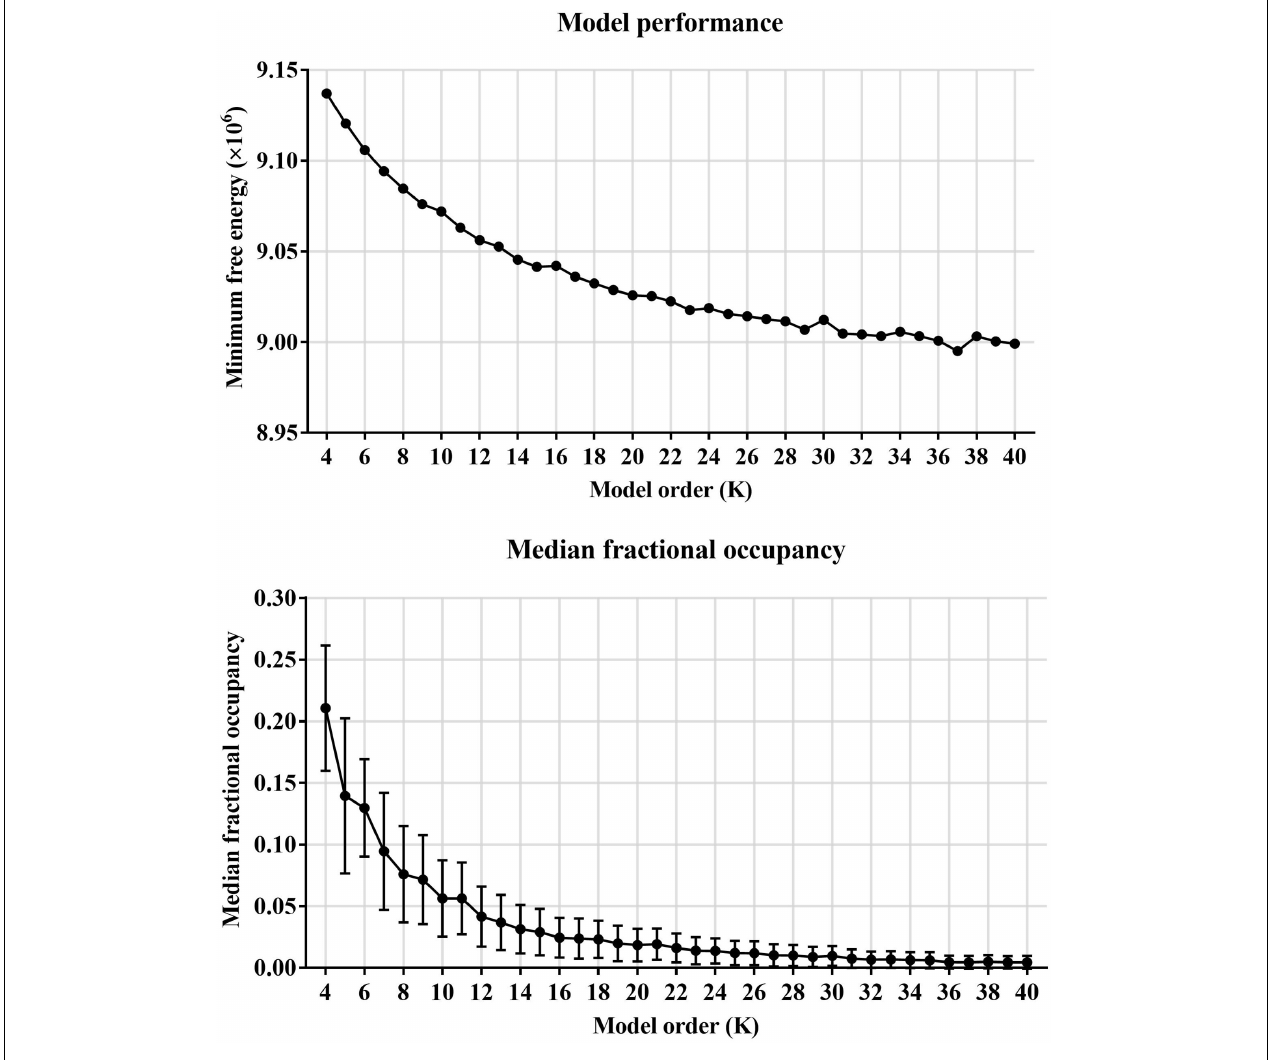
FIGURE 2 | The choice of the number of HMM